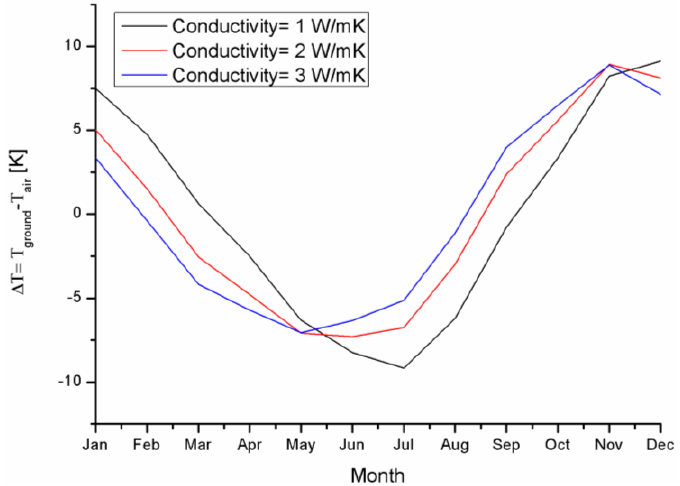
Figure 7. Difference between the ground temperature and the outdoor air